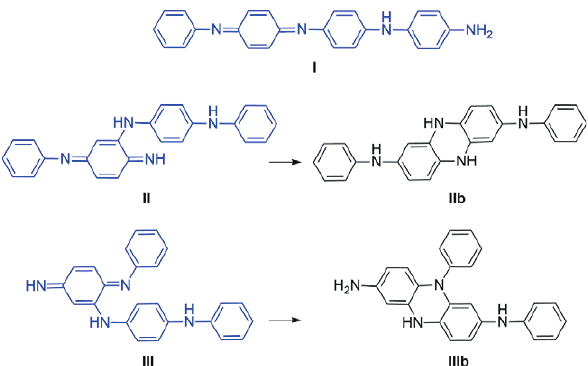
Figure 8. Possible structural motifs for the isolated blue product.